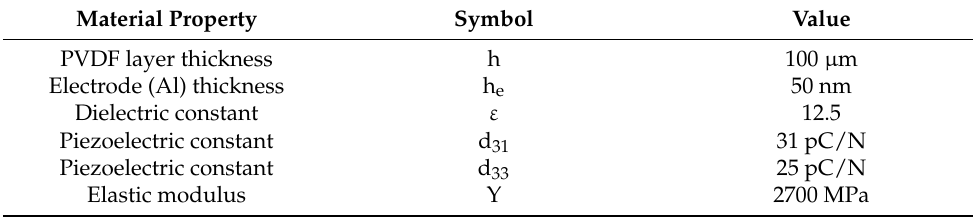
Table 1. Material Properties of PVDF Sheets